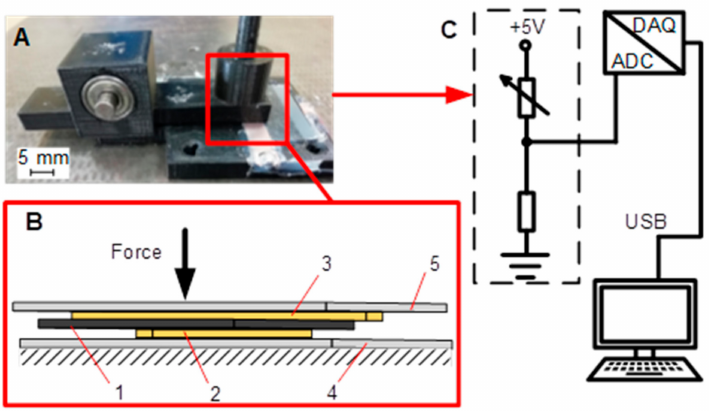
Figure 1. Design of the test rig used for experiments. ( A ) Common view; ( B ) Design of the sensor; ( C ) Electrical scheme. 1—pressure-sensitive conductive material Velostat ® , 2—fixed bottom electrode, 3—upper electrode, 4—fixed test rig plate, 5—movable test rig